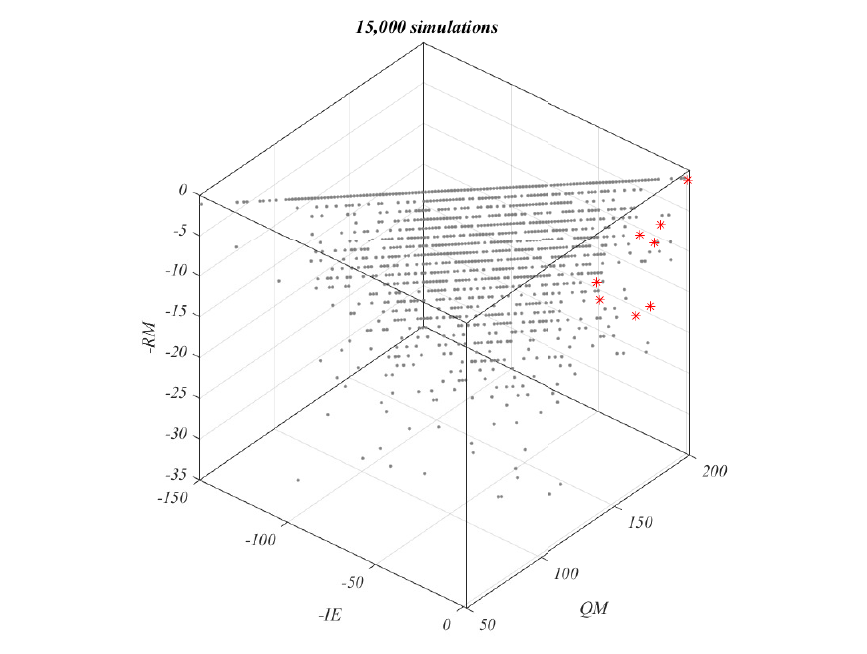
Figure 2. Search space history of multi-objective PSO with some marked designs. The Pareto optimal solutions are highlighted by red stars and non-dominated solutions with dark